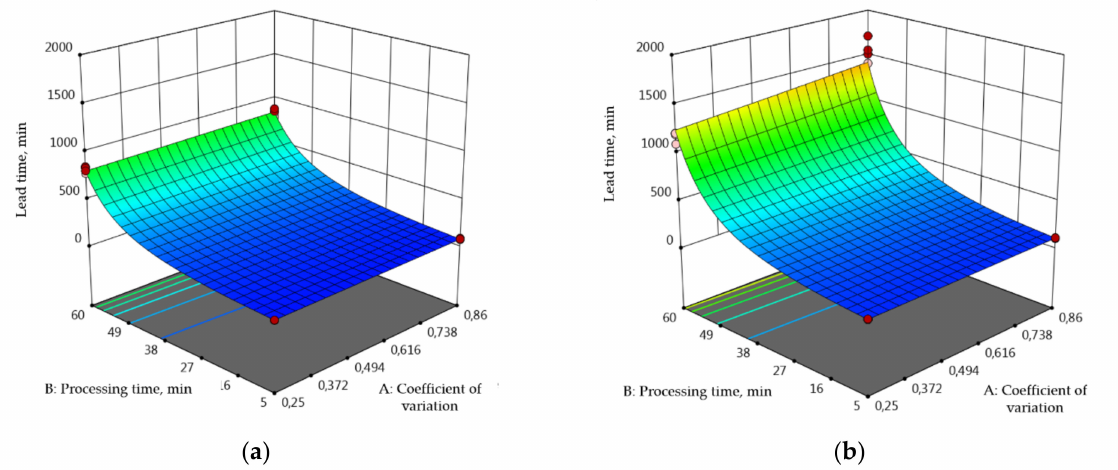
Figure 8. Response surface 3D plots: ( a ) Effects of coefficient of variation and operation time on lead time for the process with bottleneck and nine DBR cards in the whole process; ( b ) Effects of coefficient of variation and operation time on lead time for the process with bottleneck and 14 DBR cards in the whole